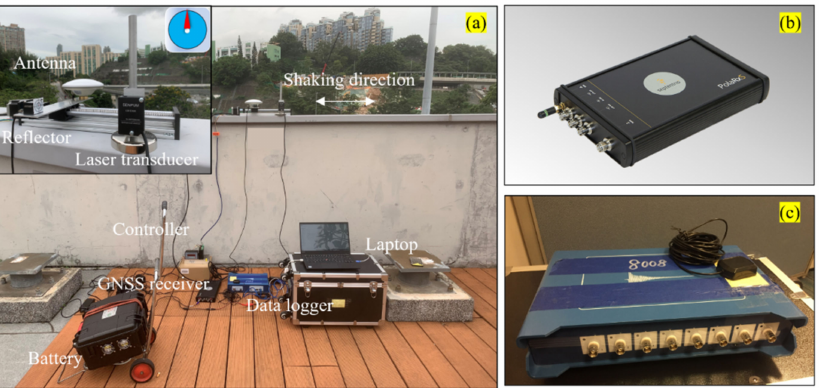
Figure 1. ( a ) Set up of experimental equipment; ( b ) Septentrio GNSS receiver (PolaRx5s) used; and ( c ) data logger with a GPS